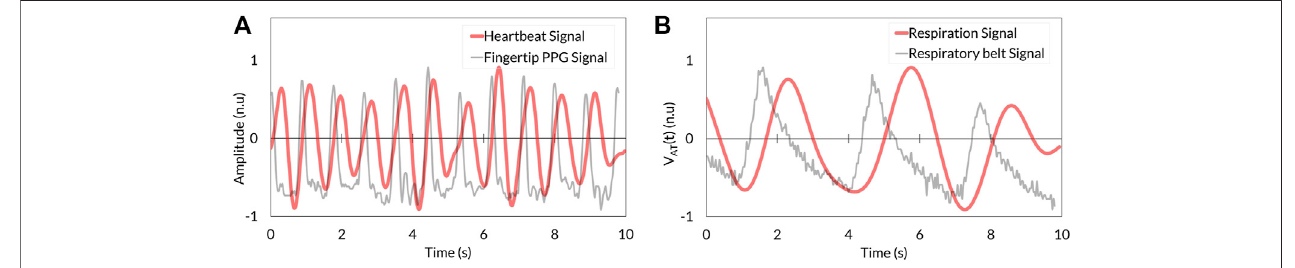
FIGURE 4 | Comparison between VISC-Camera-derived vital signals (red) and references (grey) . (A) Heartbeat signal. (B) Respiration signal. PPG, photoplethysmography.